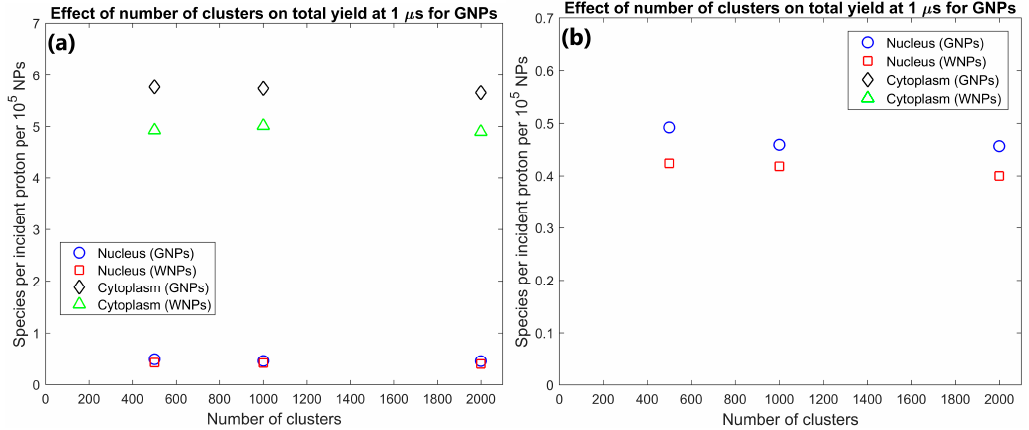
Figure 2. ( a ) Effect of GNP and WNP cluster size on reactive species yield at 1 µs from secondary electrons for cells with 70 clusters of 500 nm diameter, 1000 clusters of 200 nm diameter and 3400 clusters of 100 nm diameter within the cytoplasm. The number of clusters was chosen so that each cell contained 10 5 15 nm nanoparticles. ( b ) Highlight of nucleus yields shown in (a). The effect of the number of GNP clusters on the radiolysis yield at 1 µs per GNP in the cytoplasm and nucleus is shown in Figure 3. Overall, the yield per GNP is mostly constant indicating an effective scaling of yield with GNP concentration within the cell. There is a slight reduction in the yield per GNP from 500 to 1000 clusters of 6.7% for the nucleus and 1.4% from 1000 to 2000 clusters for the cytoplasm.